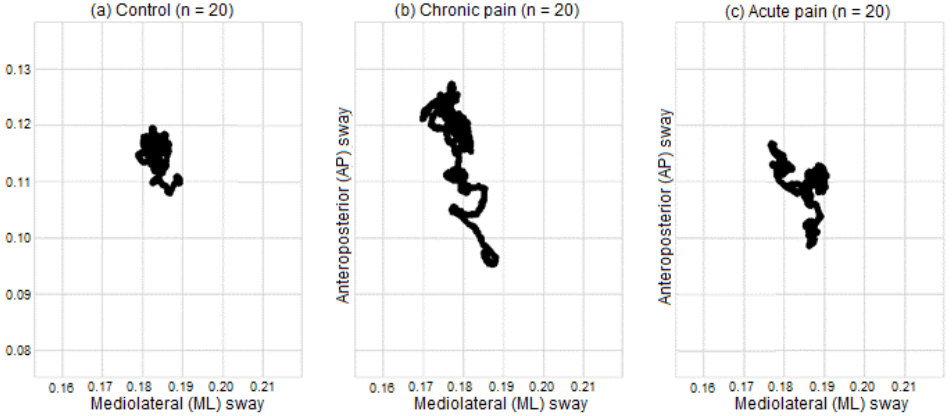
Figure 4. Pattern of body sway in typical individuals from each group. ( a ) Healthy controls, ( b ) with chronic low back pain, ( c ) patient with acute low back patient with chronic low back pain, ( c ) patient with acute low back pain.